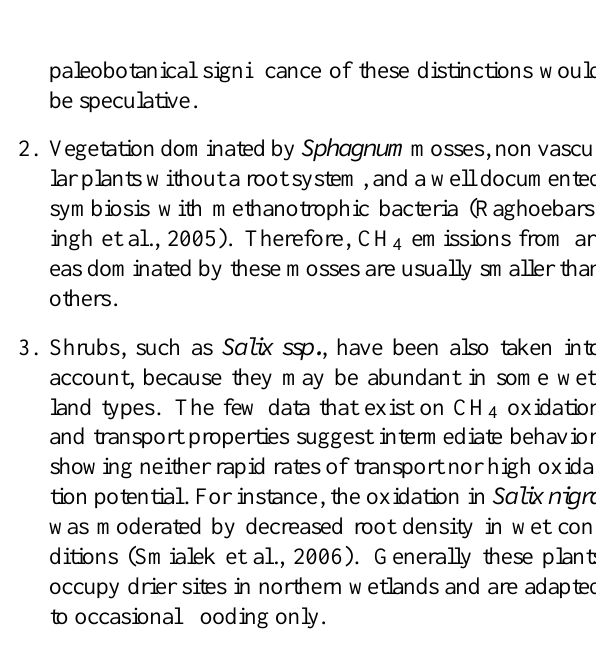
Table 1. Wetland plant functional types and their main characteristics as used in the model experiments. Wetland Description Transport Oxidation Spatial distribution vegetation type Carex type Hollow stems, Rapid to Usually low, Riparian, fens, lawns Cyperaceae, Gramineae, intermediate in rhizosphere in ombotrophic bogs often dominated by Carex Sphagnum type Dominated by Spahgnum Minimal High inside plant Ombrotrophic bogs, hummocks and pools Shrubs Salix and other species Intermediate Intermediate Riparian, resistant to wet conditions ombrotrophic,